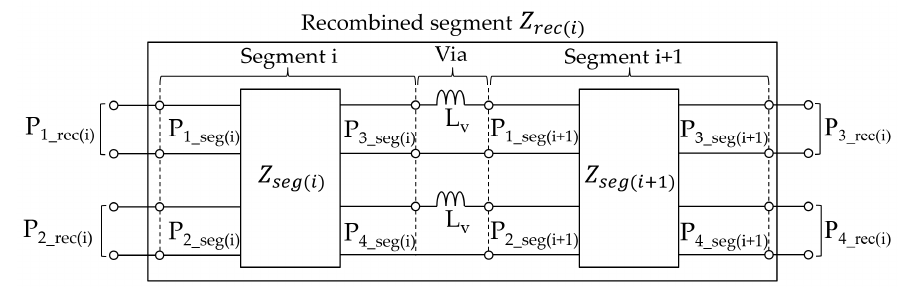
Figure 4. Block diagram to derive recombined Z-parameter using segmentation method.